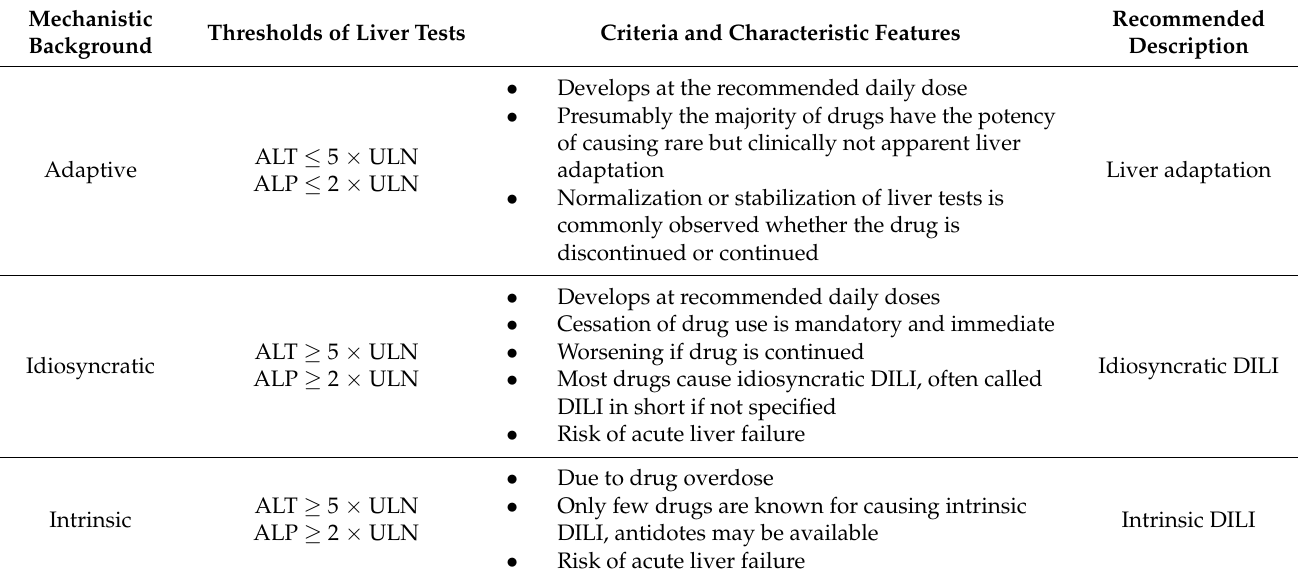
Table 1. Criteria of liver adaptation and liver injury